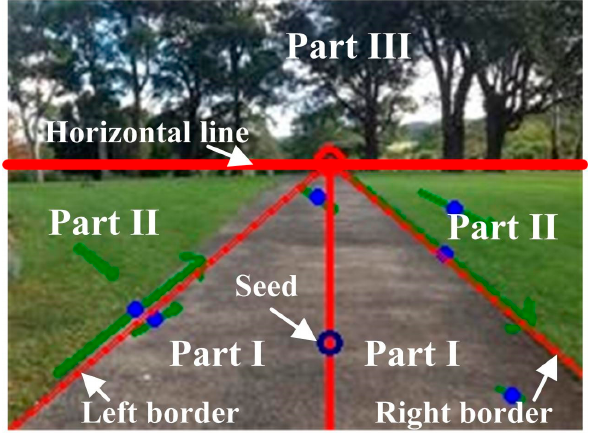
Figure 4. Traversable region segmentation starting from the seed with region growing. The region between left and right border is Part I; the region above horizontal line is Part III and the rest of the image part is Part II.